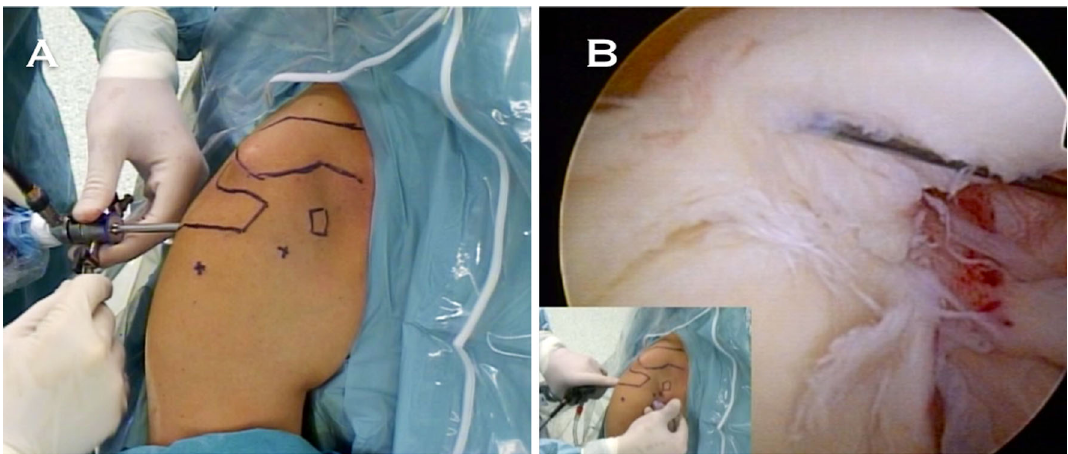
Fig. 2 a Anterolateral perspective of a right shoulder positioned in the operating room, with a history of a chronic grade V ACJ injury. b Biceps-labrum complex viewed from the posterior portal. Notice